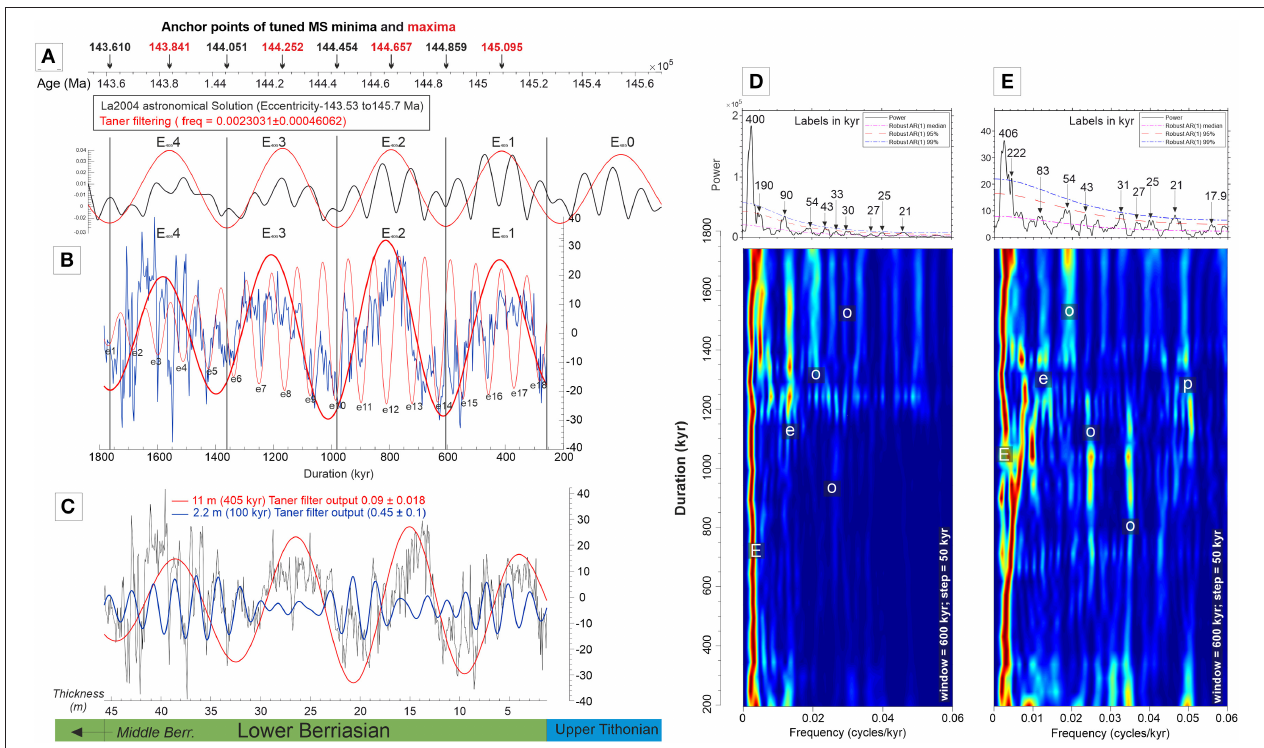
FIGURE 8 | Orbital tuning of the MS series at Jebel Meloussi locality, and geochronology of the lower Sidi Khalif Formation. (A) 405 kyr filter output of the La2004 astronomical solution (from 145.53 to 145.7Ma). (B) 405 and 100 kyr filter output of the tuned MS stratigraphic series. Duration estimate points to ∼ 1.6 Myr with a mean SAR of ∼ 2.7 cm/kyr. (C) 11m (405 kyr) and 2.2m (100 kyr) Taner filter output of the untuned MS series. (D) Spectral analysis (2 π -MTM + evolutionary FFT) of the 405 kyr-tuned MS series and (E) % CaCO 3